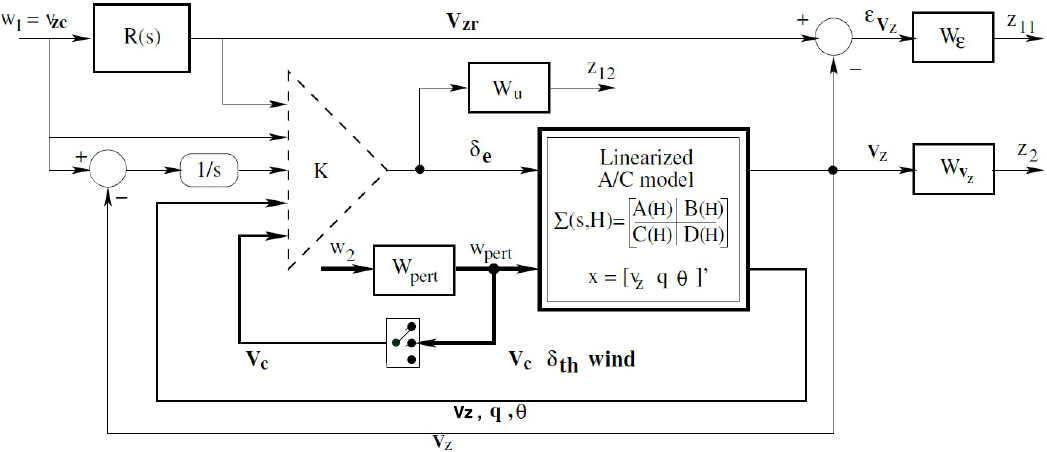
Figure 4. Design